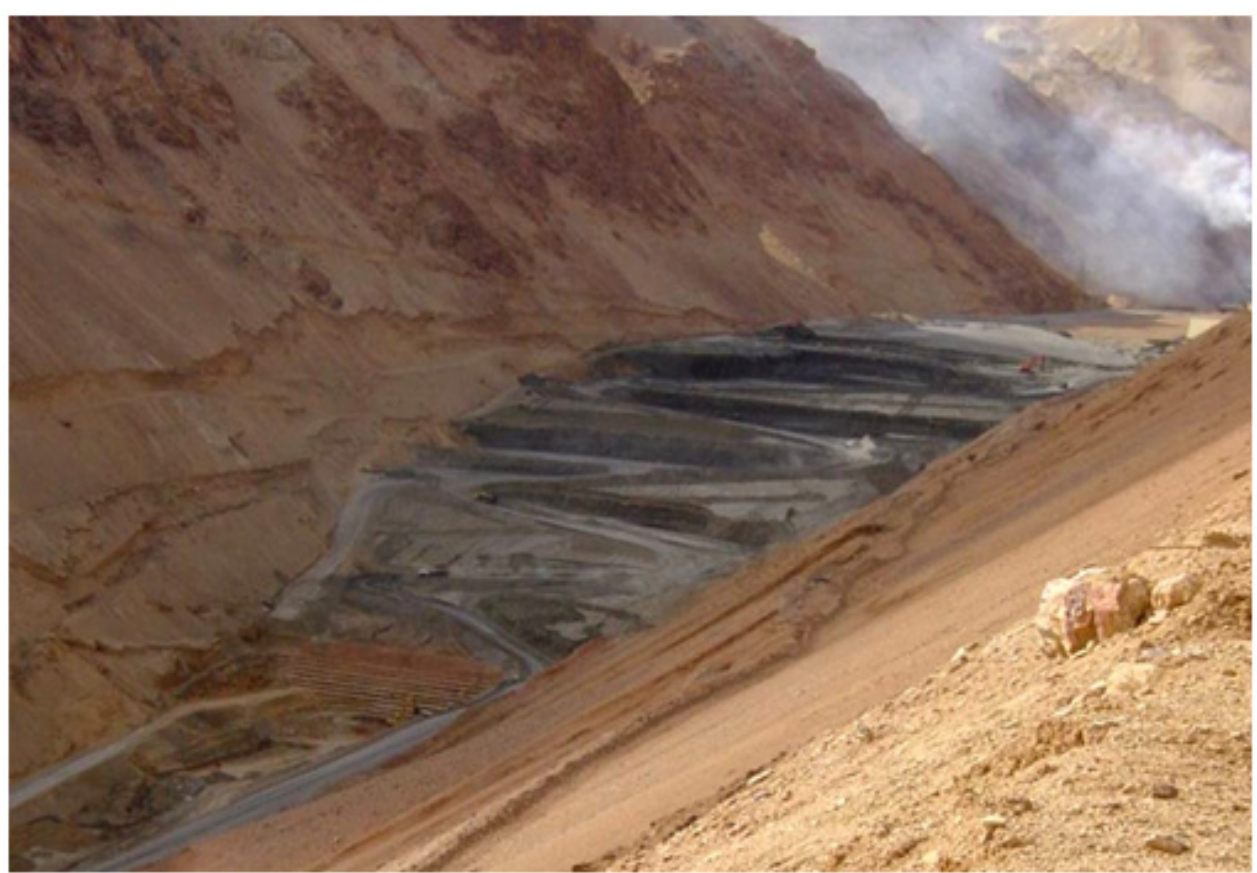
Figure 21. El Indio Filtered TSF Front View [53].